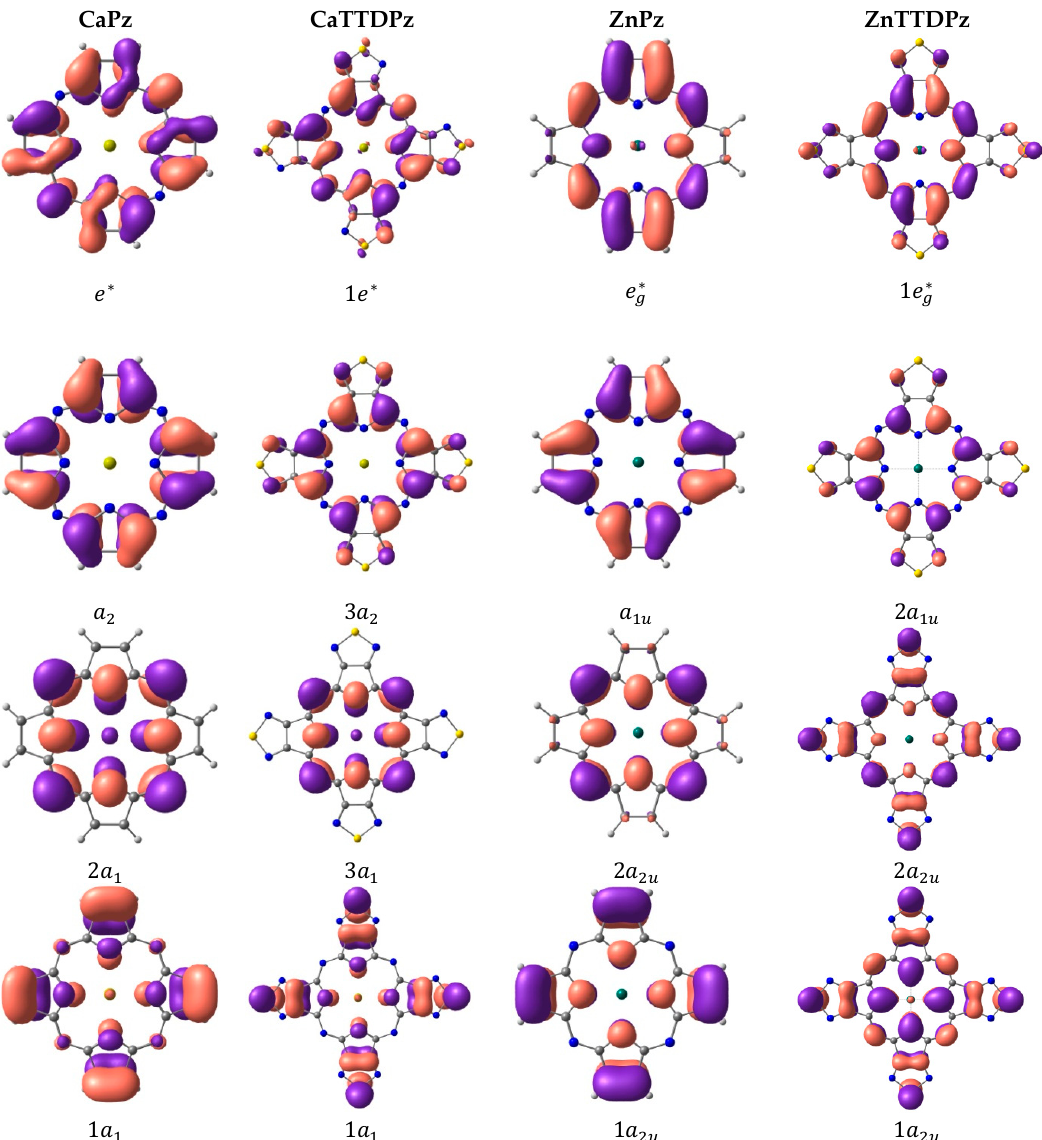
Figure 5. Influence of the metal (Ca/Zn) and ligand (Pz/TTDPz) on the molecular orbitals of MPz and MTTDPz complexes.